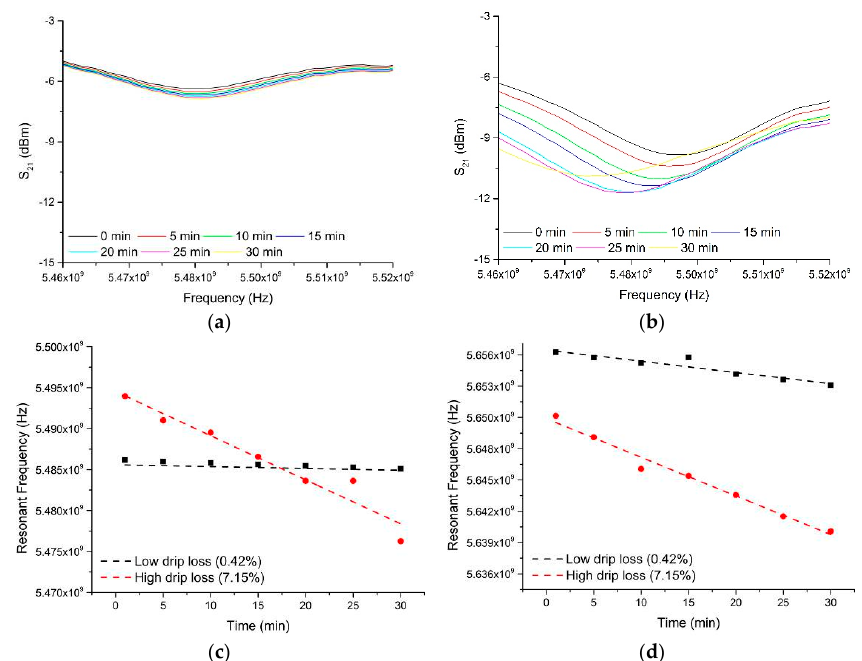
Figure 8. The microwave spectra between 5.46 and 5.52 GHz for two samples; one with ( a ) low drip loss (0.42%) and one with ( b ) high drip loss (7.15%) as determined by EZ-Driploss measurements. The change in resonant frequency in the range ( c ) 5.47 to 5.50 GHz and ( d ) 5.636 to 6.656 GHz are demonstrated and compared for the high and low drip loss samples.